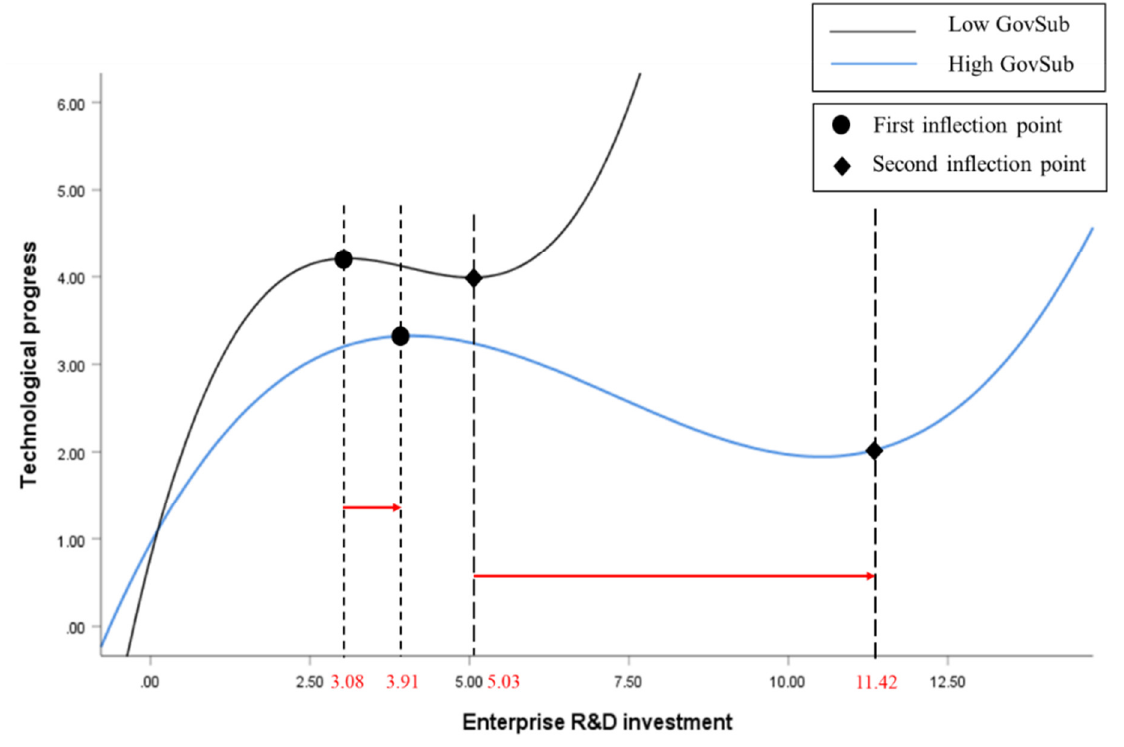
Figure 8. The moderating effect of government subsidies. Note: Enterprise R&D investment and technological progress are dimensional parameters. Source: Produced by the authors from the sample data using SPSS 16.1.